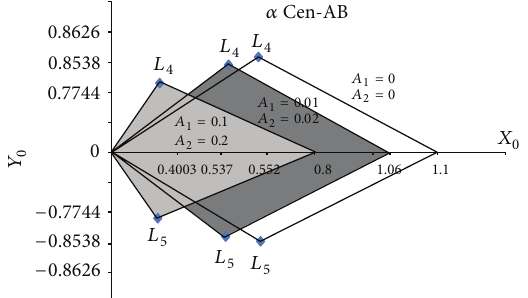
Figure 3: Location of triangular points for Achird with 𝐴 1 = 𝐴 2 = = 0.01, 𝐴 = 0.02 , and 𝐴 0, 𝐴 1 2